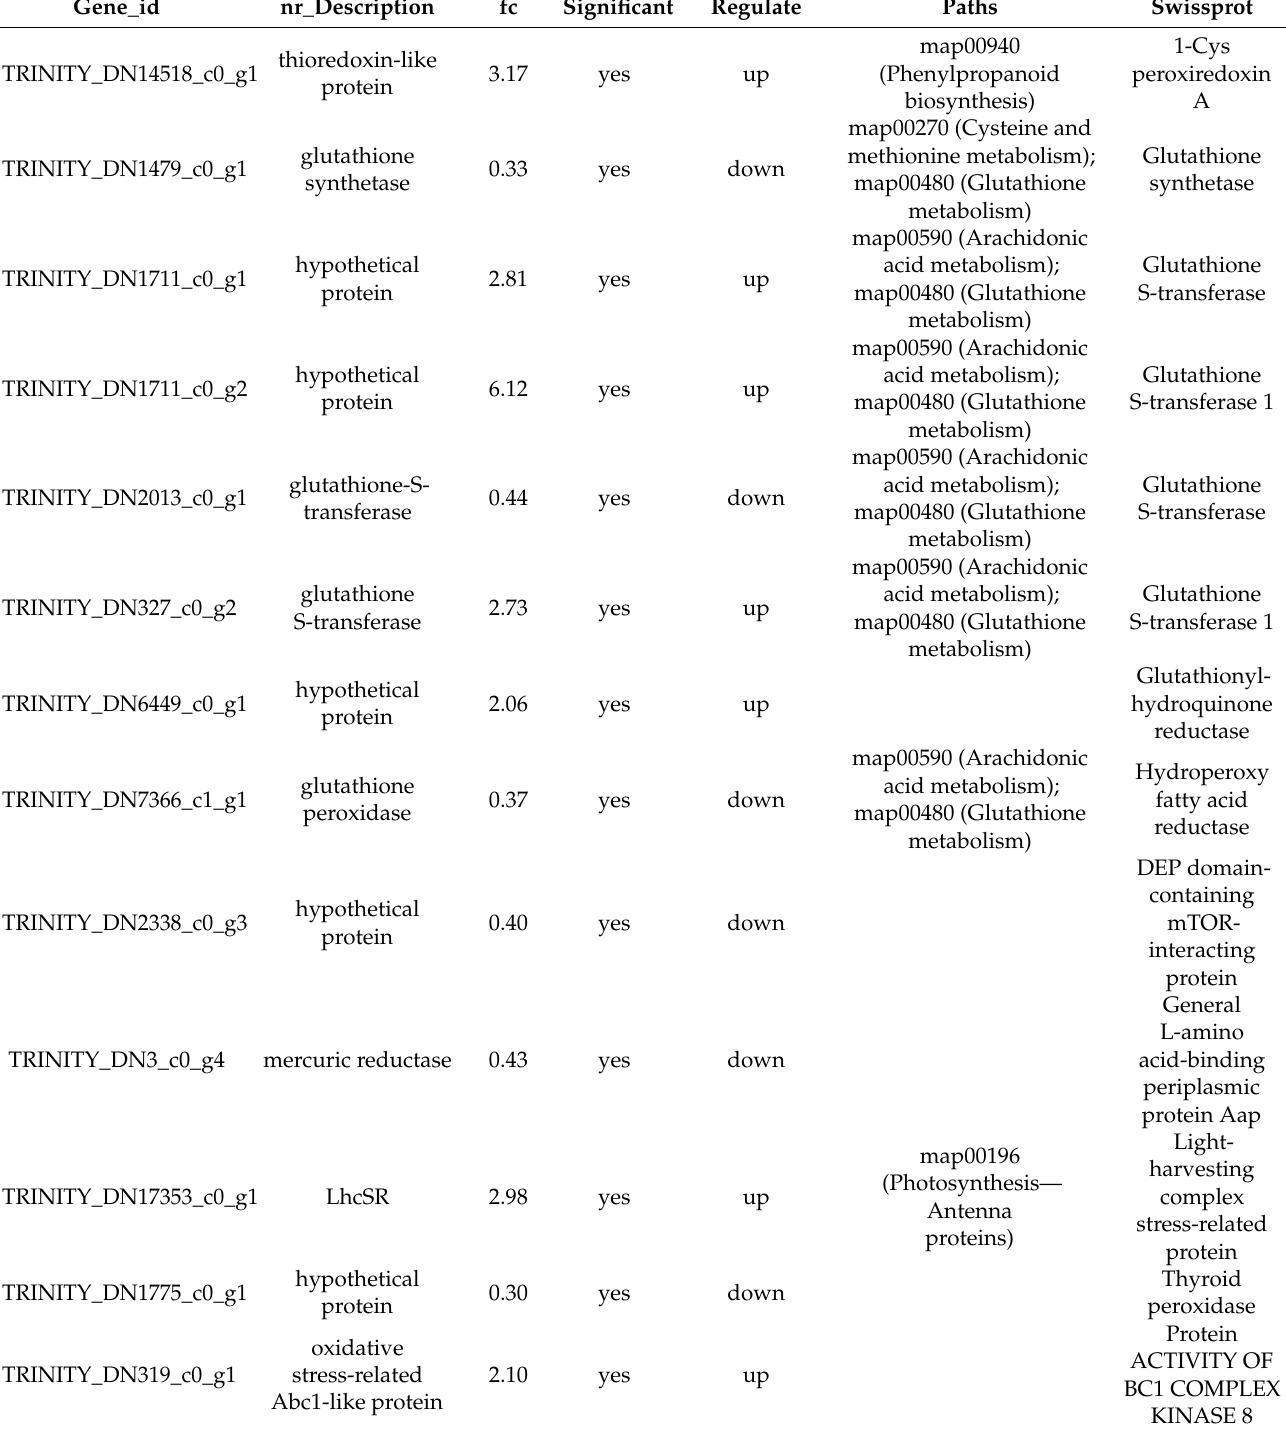
Table 4. DEGs involved in heavy metal stress response in C. fusiformis under Zn 2+